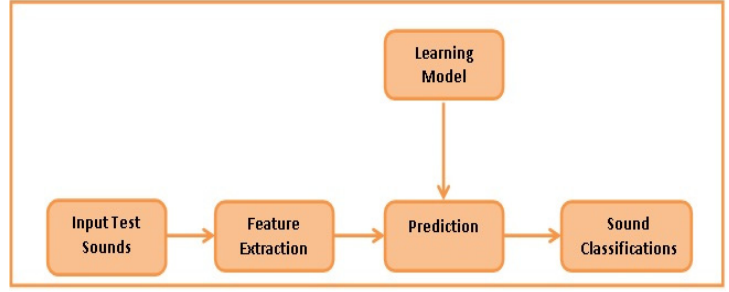
Figure 6. Testing process of dog sounds.